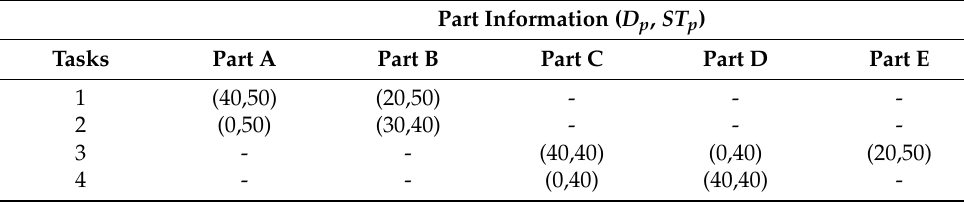
Table 2. Part information represented in the cell formation structure for the example problem.